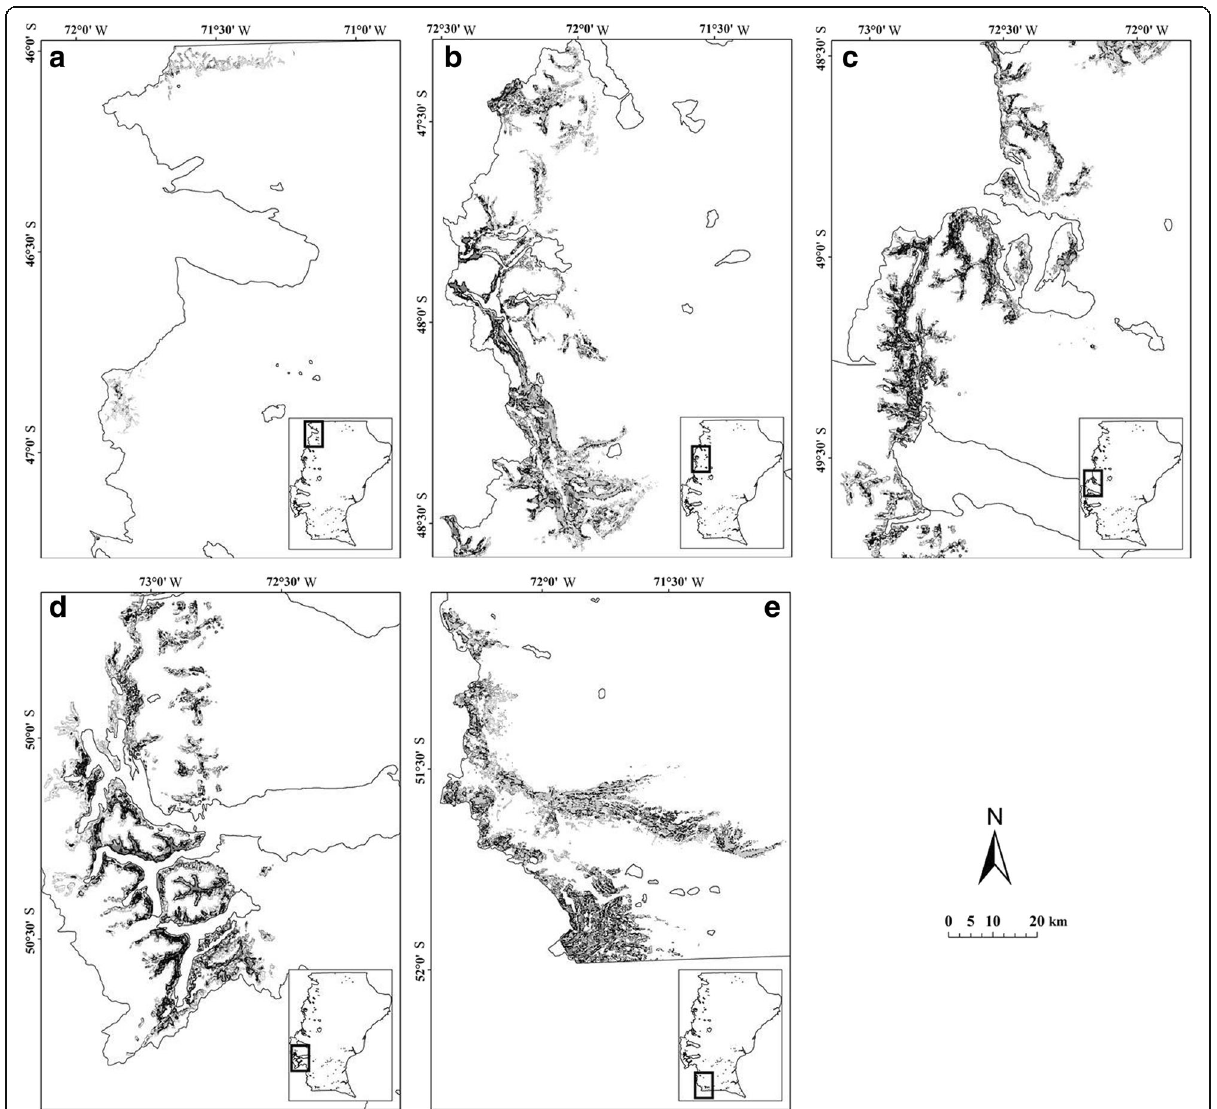
Fig. 3 Habitat suitability map of huemul, where light gray showed lower potential (40 – 50%), dark gray showed medium potential (50 – 70%), and black showed higher potential (70 – 100%) areas. White showed unsuitable areas (values <40%). a Lago Buenos Aires, b Lago Pueyrredón, c